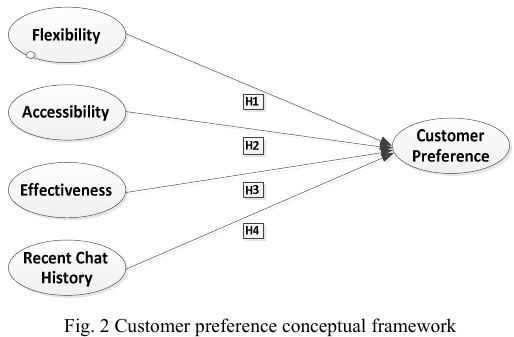
Fig. 2 Customer preference conceptual framework